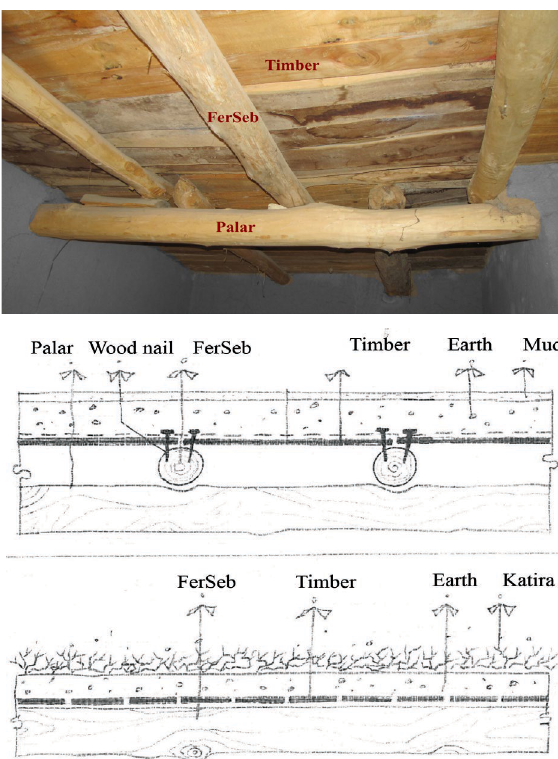
Figure 14. How does the Takhte-Poosh run? The natives use mud and salt to prevent water from penetrating the roof. Katira is also used for reinforcement at the edge of the walls, author. 2.2.2